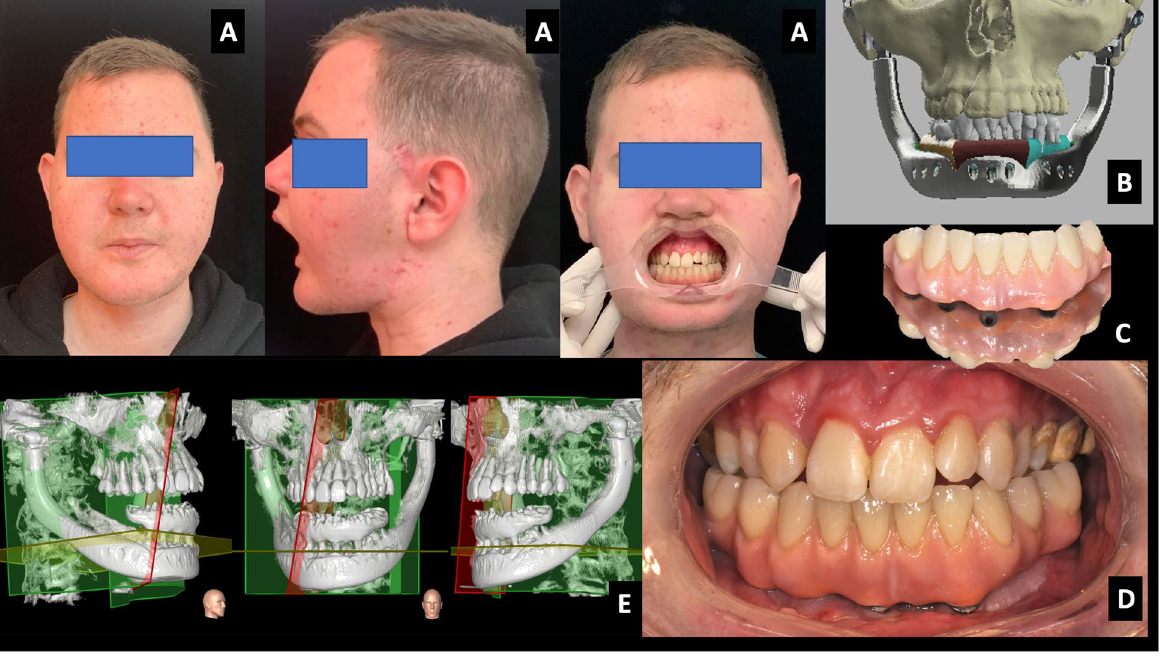
Fig. 8 The final result at the 18 th -month follow-up a patient views, note the mouth opening in lateral view and the dental occlusion, b the pre-treatment 3D-VSP (virtual surgical plan) in comparison with the obtained results, c the final dental prosthesis, d the 3D CT scan at the end of the treatment, and e the final occlusal